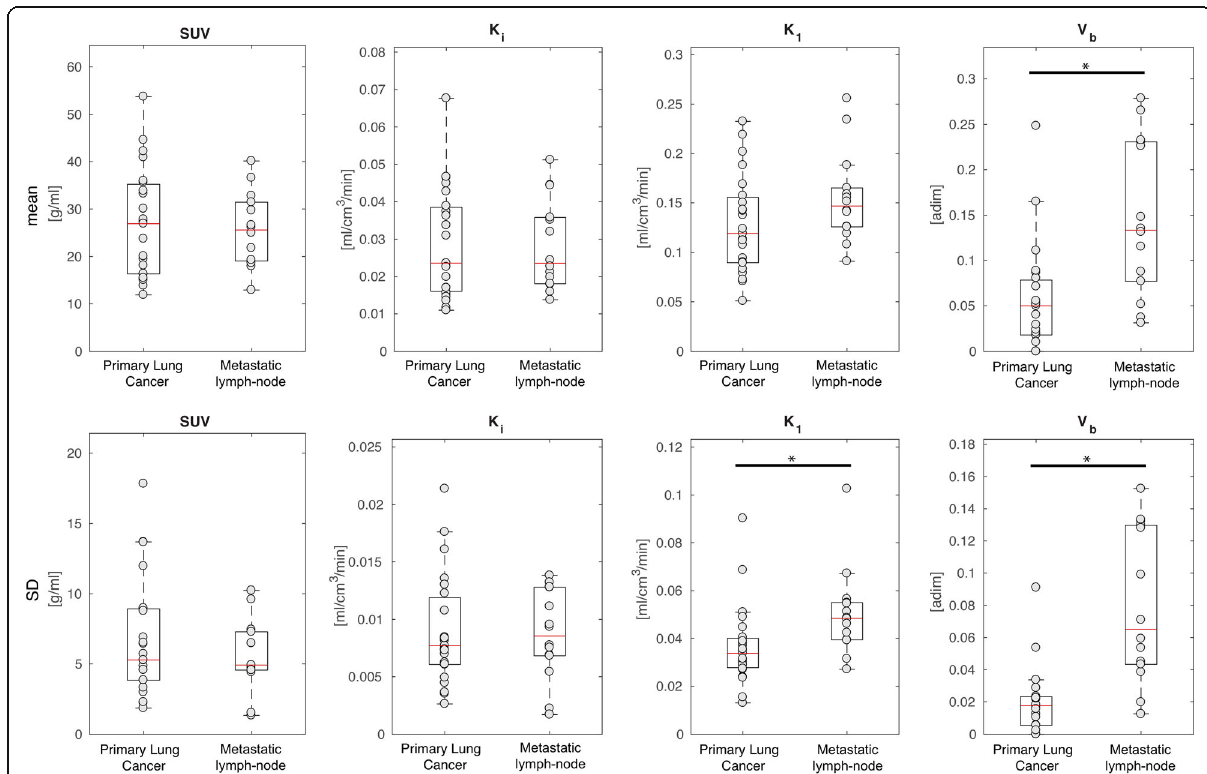
Fig. 2 Comparison of quantitative parameters estimated by 3K model in primary lung cancers and metastatic lymph nodes. Box plot of mean values (top row) and standard deviation (SD, bottom row) of K i , K 1 and V b , respectively, in primary lung cancers ( n = 23) and metastatic lymph nodes ( n = 24). The individual values making up the box plot are shown as grey points. In the box plots, the red line indicates the median value and the edges of the box plot are the 25th and 75th percentiles, whereas the star (*) indicates statistically significant differences between the two groups ( p < 0.05, Wilcoxon rank-sum